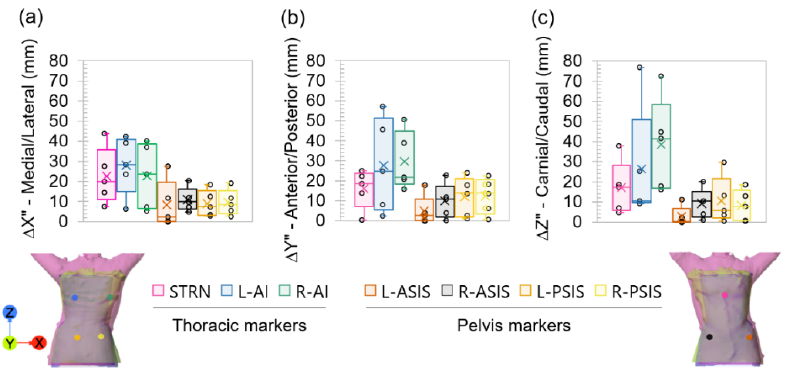
Figure 5. ALP deviations between the patient’s body and the post-rectification mould. ( a ) represents the ALP deviations in the medial/lateral direction ( ∆ X”), ( b ) represents the ALP deviations in the anterior/posterior direction ( ∆ Y”), and ( c ) represents the ALP deviations in the cranial/caudal direction ( ∆ Z”). STRN, L-AI, and R-AI are at the thoracic level on the anterior (STRN) and posterior (L-AI and R-AI) sides, while L-ASIS, R-ASIS, L-PSIS, and R-PSIS are at the anterior (L-ASIS and R-ASIS) and posterior (L-PSIS and R-PSIS) sides of the pelvis. Mean deviations are represented by a cross, while median deviations are represented by a horizontal line. Top and bottom whiskers represent the maximum and minimum deviations.